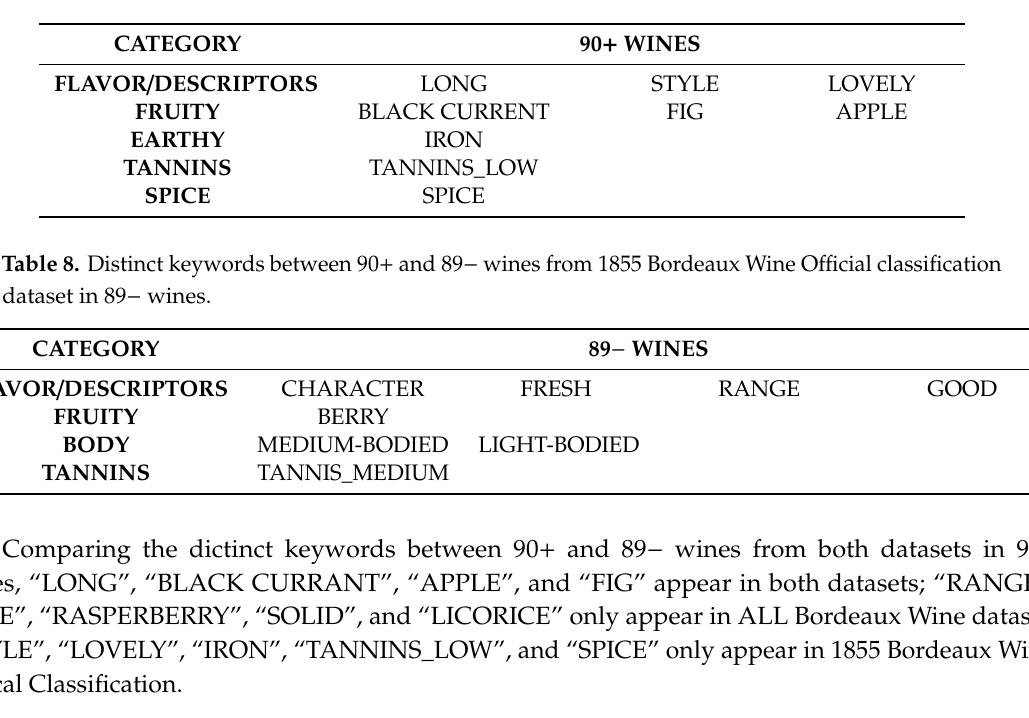
Table 7. Distinct keywords between 90 + and 89 − wines from 1855 Bordeaux Wine O ffi cial classification dataset in 90 + wines.